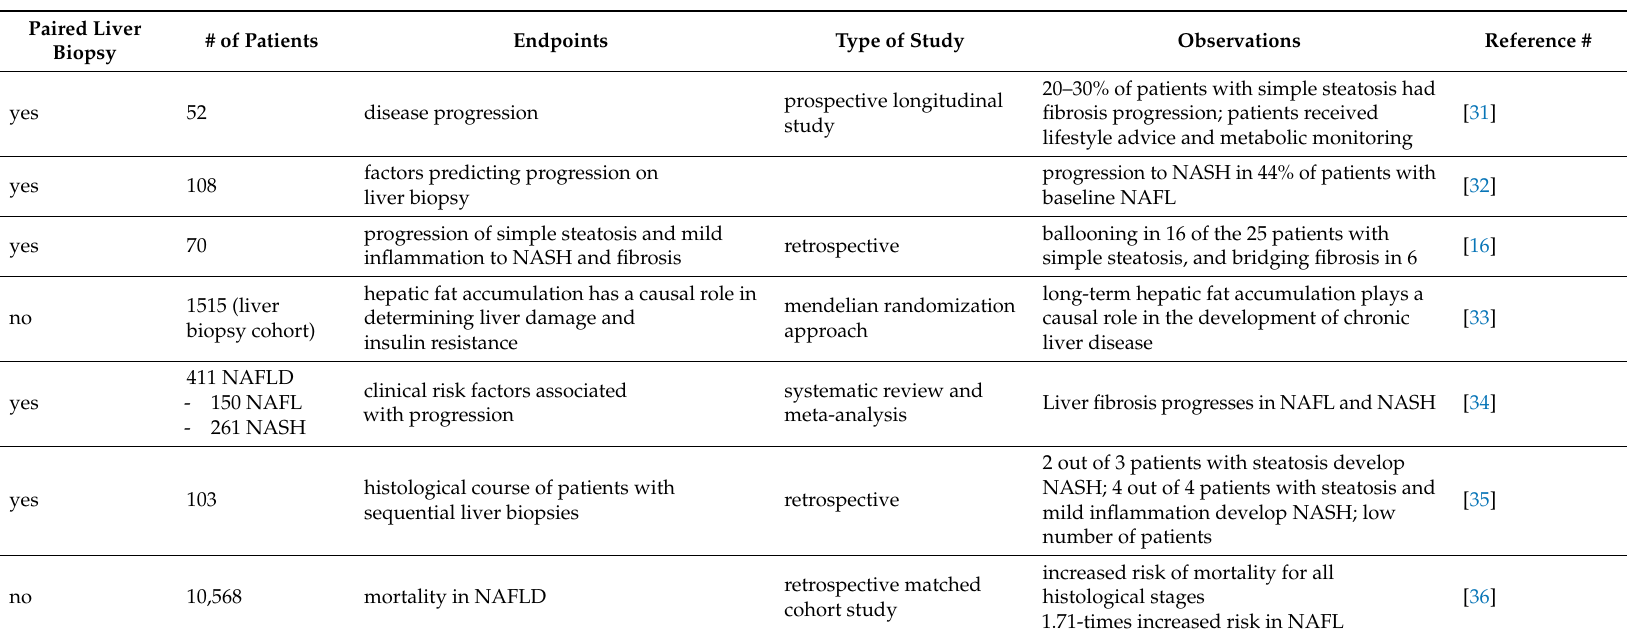
Table 2. Evidence in favor of the poor prognosis of NAFL patients (5 out of 6 with paired liver